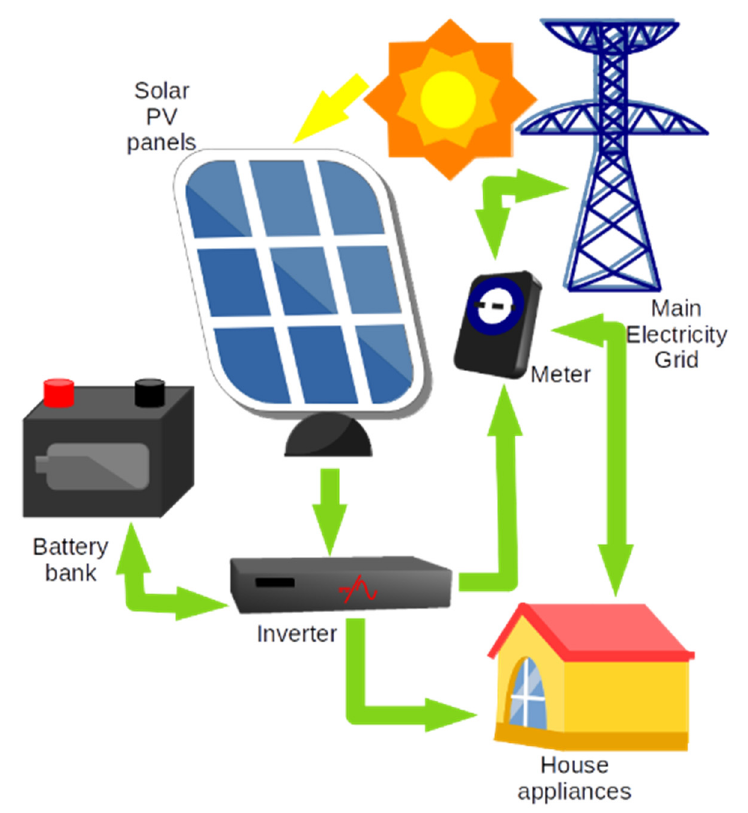
Figure 2. Photovoltaic (PV) system.